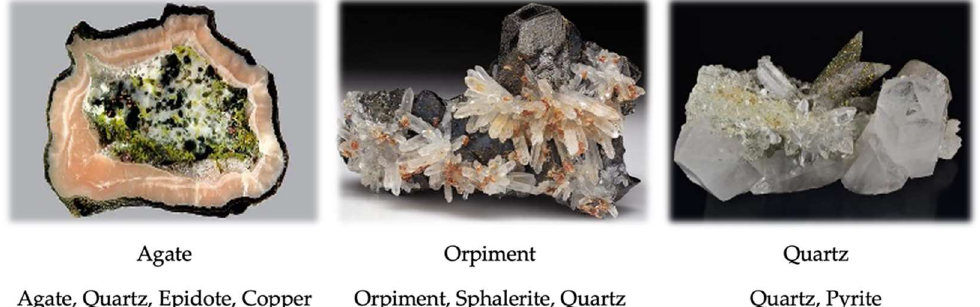
Figure 1. Three example images in our dataset. The first row is the single label used by Zeng et al. [4], and the second row is the multi-labels used in the paper. Table 2. Mineral names and the number of labels for each mineral.